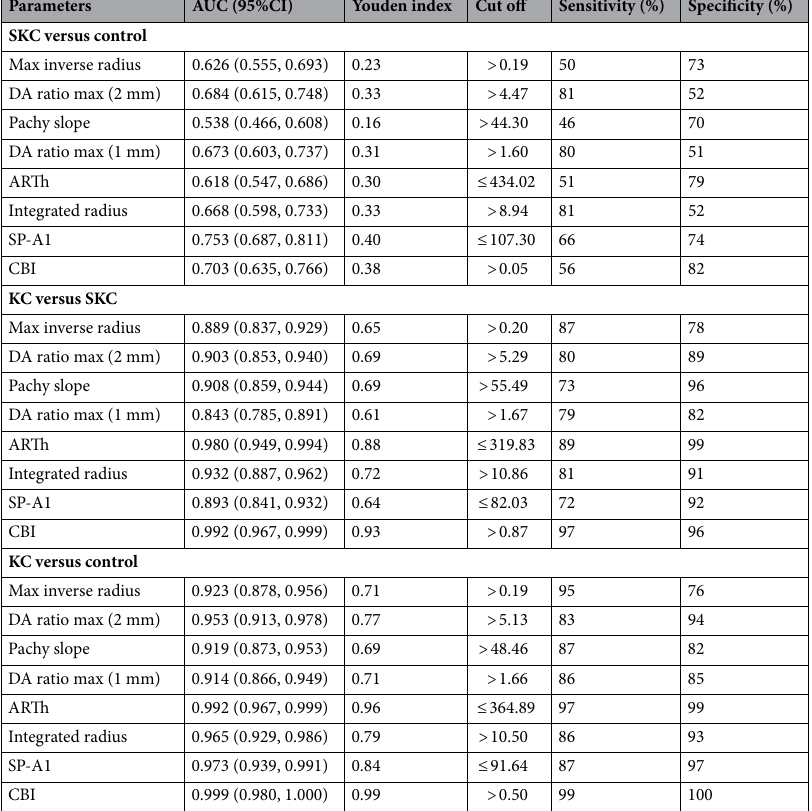
Table 3. Accuracy of new Corvis ST parameters in identifying SKC and KC eyes. SKC Subclinical keratoconus, KC Keratoconus, DA Deformation amplitude, ARTh Ambrósio’s relational thickness horizontal, bIOP Biomechanical corrected intraocular pressure, SP-A1 Stiffness parameter at the first applanation, CBI Corvis biomechanical